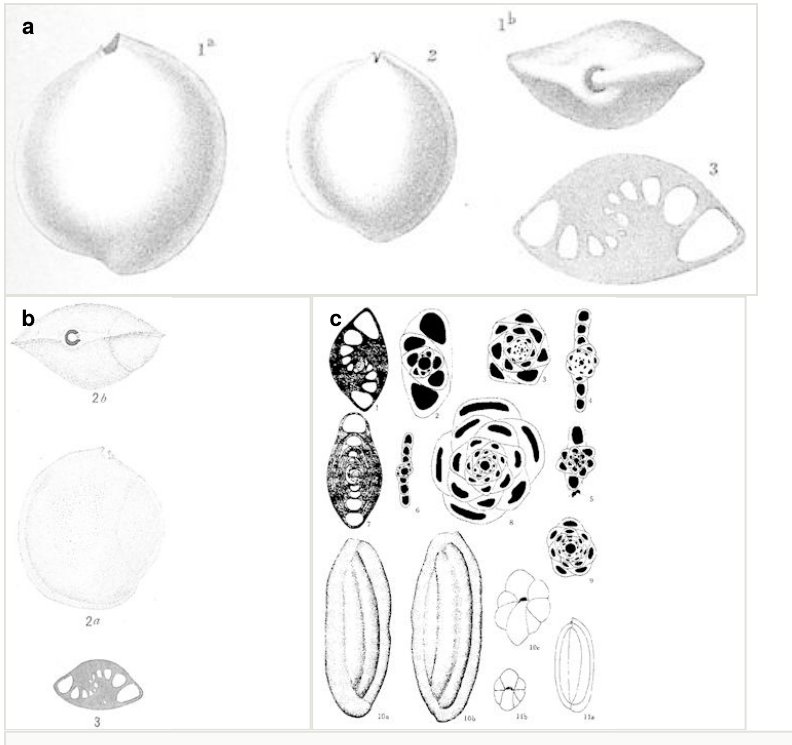
Figure 5. Time series of taxonomic illustrations depicting Sigmoilina (Chromista: Foraminifera: Miliolida: Hauerinidae) in standard